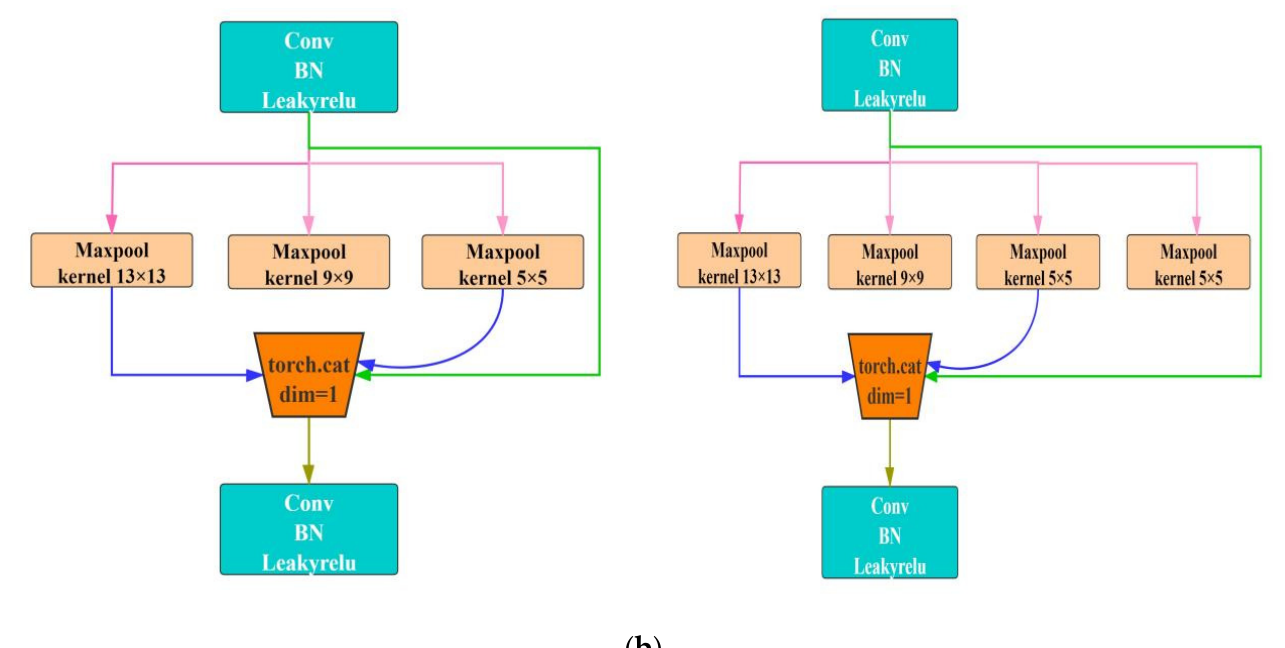
Figure 7. Comparison before and after pooling layer improvement: ( a ) macro structure; ( b ) micro structure.